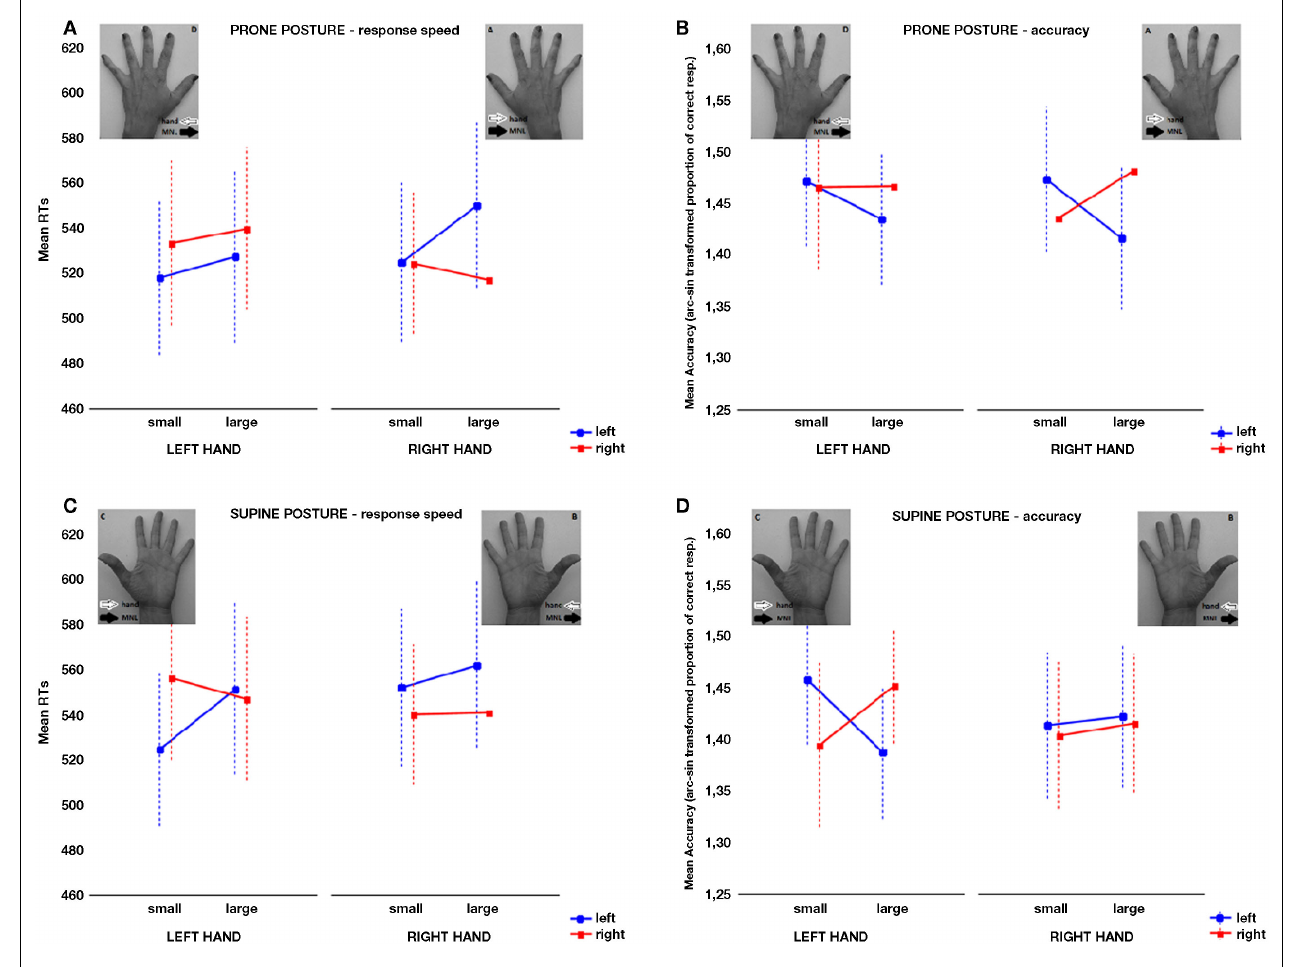
units [ T (47) = 3.27, P = 0.001, r = 0.43; M = − 0.21, SE =